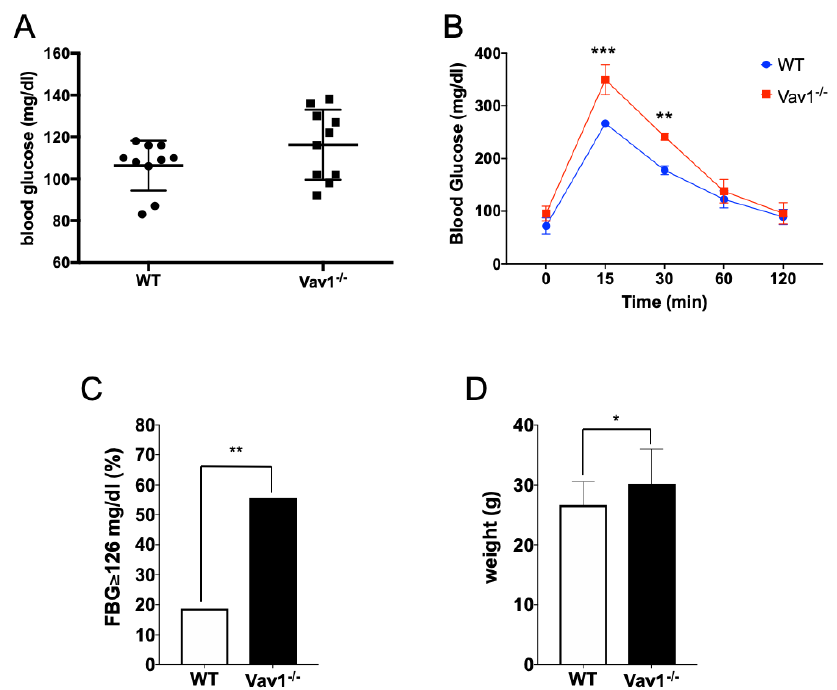
Figure 3. Vav1 deficiency delays glucose distribution in vivo. 8-week old female wild type or endothelial Vav1-deficient mice have fasted for 12 h in the presence of water. ( A ) Blood glucose levels were measured from the tail tip of each mouse ( n = 10/group). ( B ) After 12 hours’ fasting, mice were given with 2 g/kg of glucose intraperitoneally. The blood glucose level was measured at each designated time point ( n = 10/group). ( C ) The percentage of animals with 126 mg/dl or higher fasting blood glucose (FBG) in the basal state is displayed ( n = 12/group). ( D ) The weight of mice measured after 12-h fasting ( n = 12/group). Mean ± SD, * p < 0.05, ** p < 0.01, *** p < 0.001.